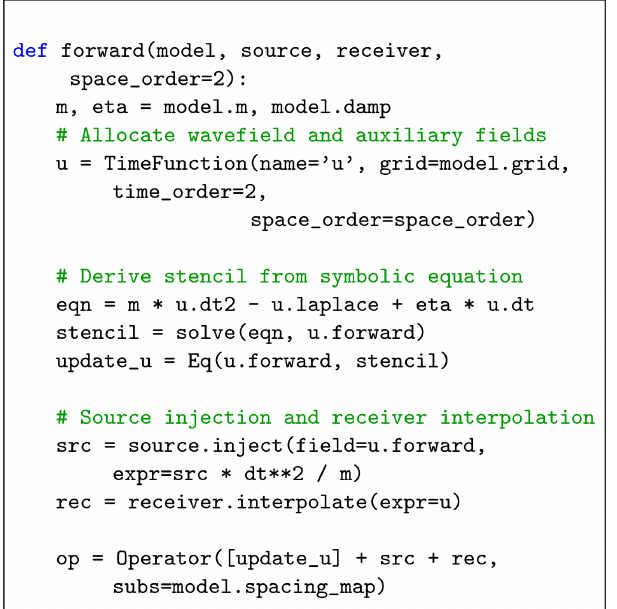
Figure 4. Example definition of a forward